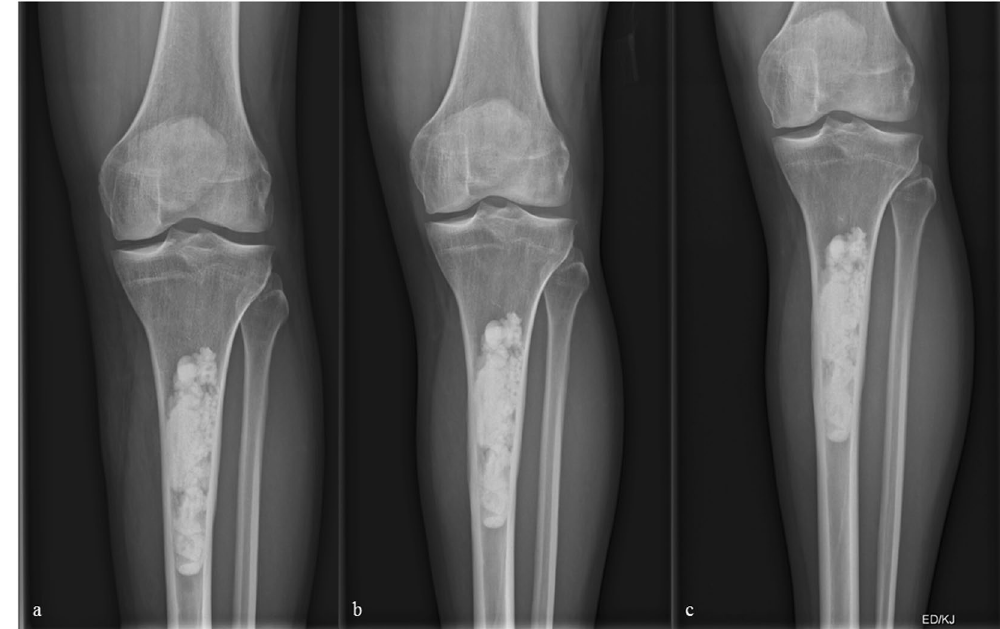
Figure 1. ( a – c ) X-ray of a 36 year-old male patient few days following curettage of a low-grade chondrosarcoma of the left proximal tibia. ( b and c ) Follow-up radiographs 7 and 13 months following index surgery showing integration but no resorption of the artificial bone graft